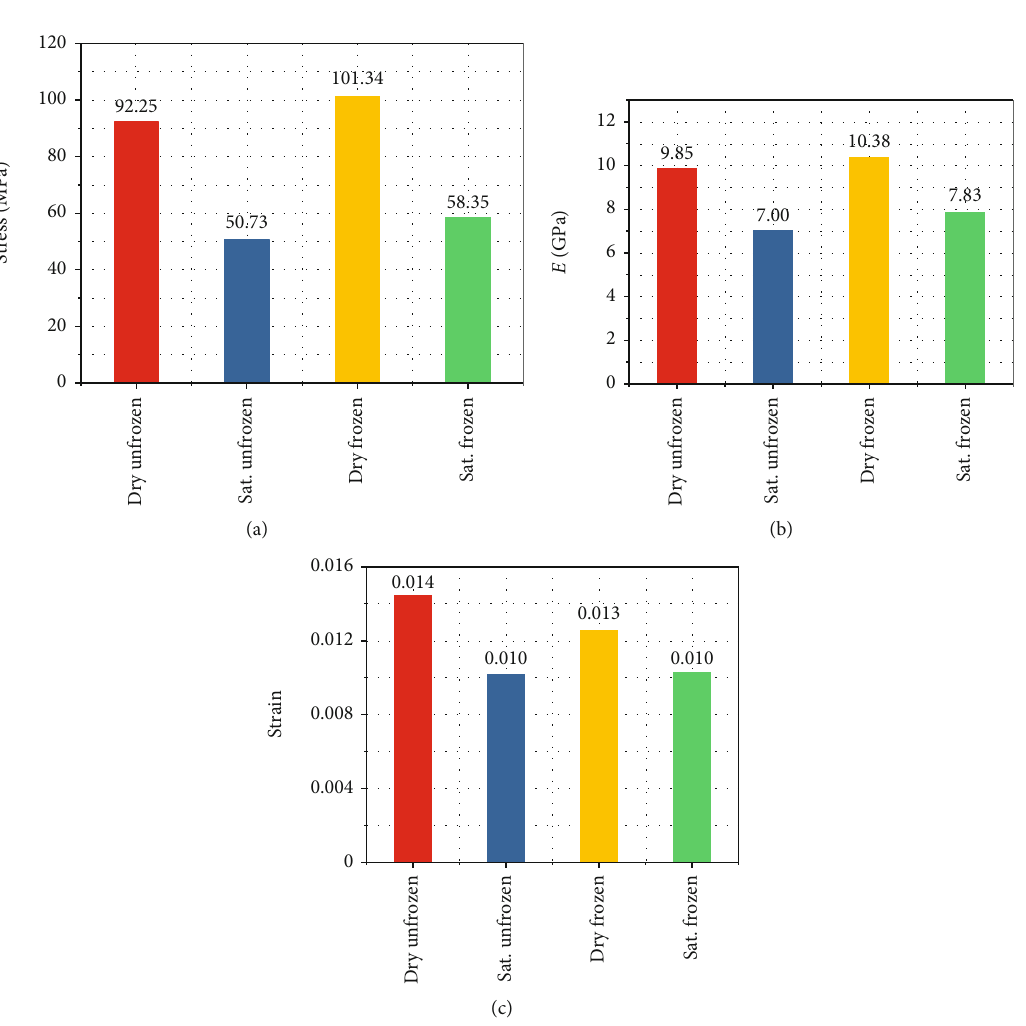
Figure 6: The (a) UCS, (b) E , and (c) failure strain values of specimens under uniaxial